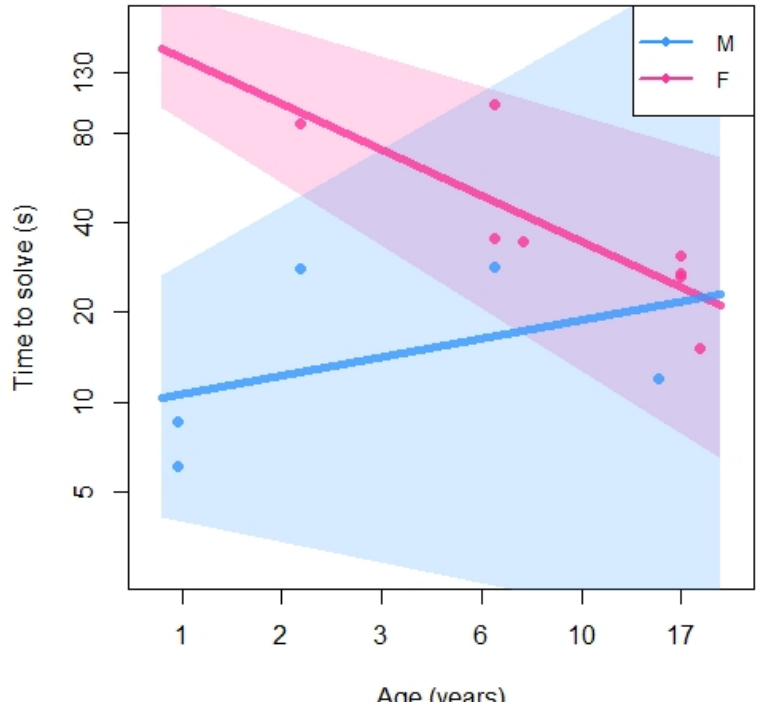
Term estimate SE lower CI upper CI t df P min max Intercept 1.690 .102